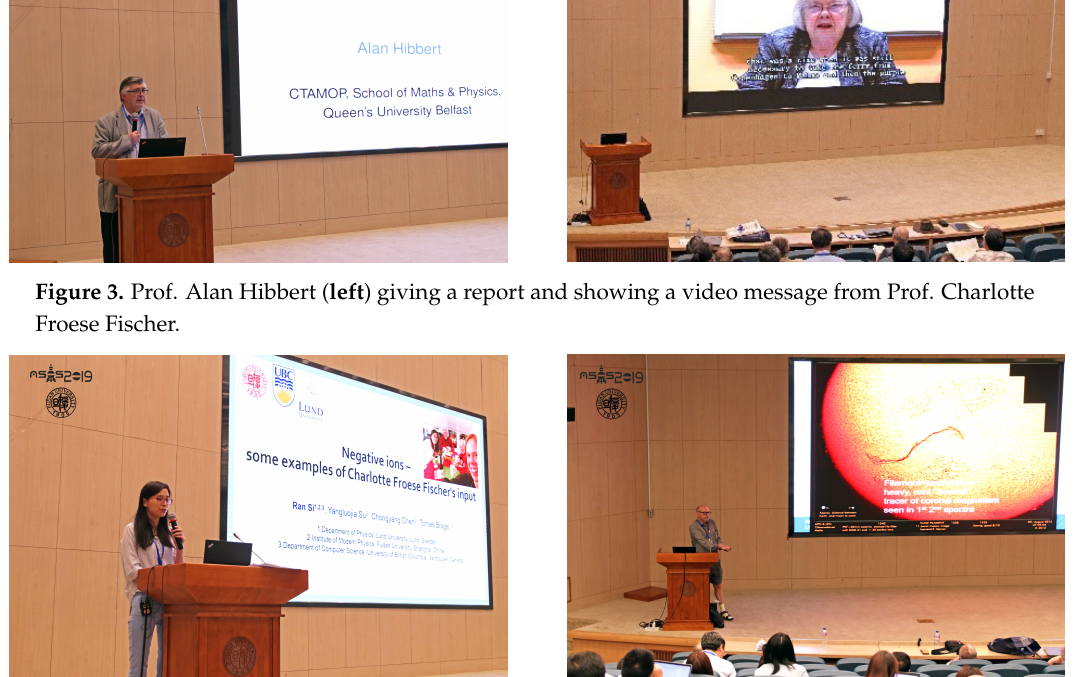
Figure 4. Drs. Ran Si ( left ) and Philip Judge giving